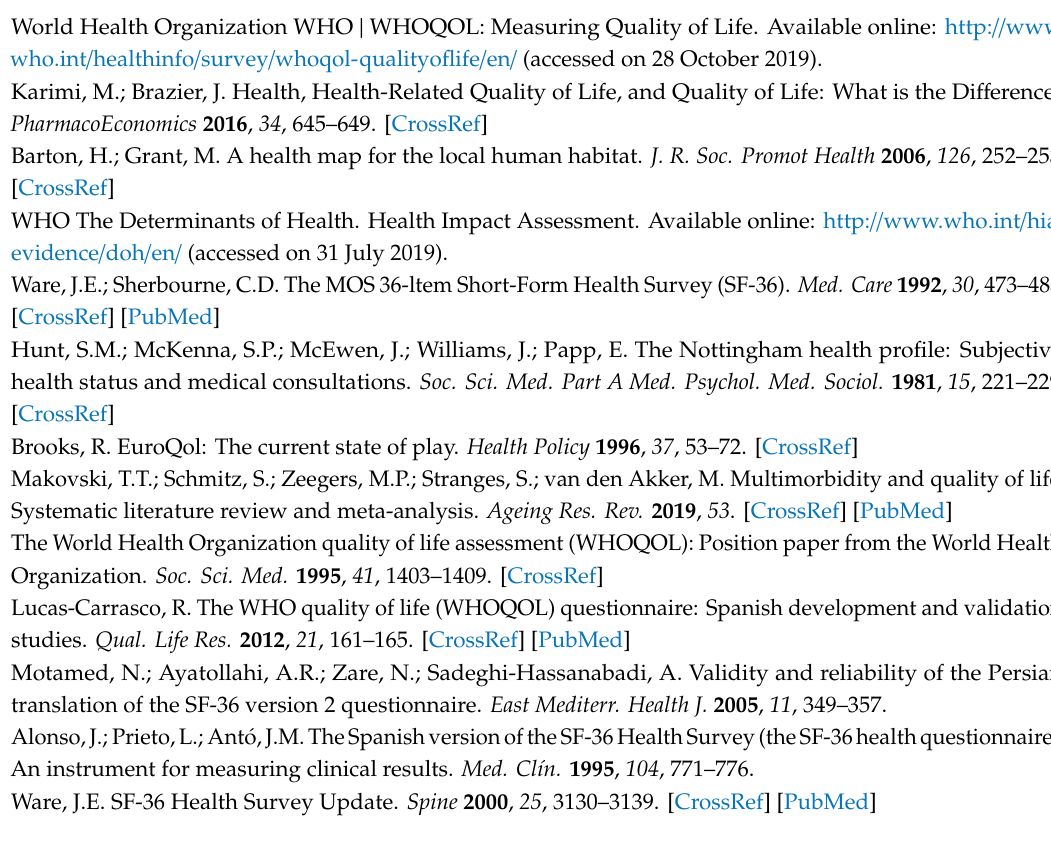
Table S1: Regression Models with β -regression coe ffi cients and 95% confidence interval of the contributing dietary characteristics of the sample for the global and physical summary scores of the SF-36. Subgroup analysis by sex, Table S2: Regression Models with β -regression coe ffi cients and 95% confidence interval of the contributing dietary and lifestyle characteristics of the sample for the mental and transition summary scores of the SF-36. Subgroup analysis by sex, Table S3: regression models with β -regression coe ffi cients and 95% confidence for each of the physical and mental component scales, Table S4: regression models with β -regression coe ffi cients and 95% confidence interval of the contributing dietary characteristics of the sample for each of the physical and mental subscale